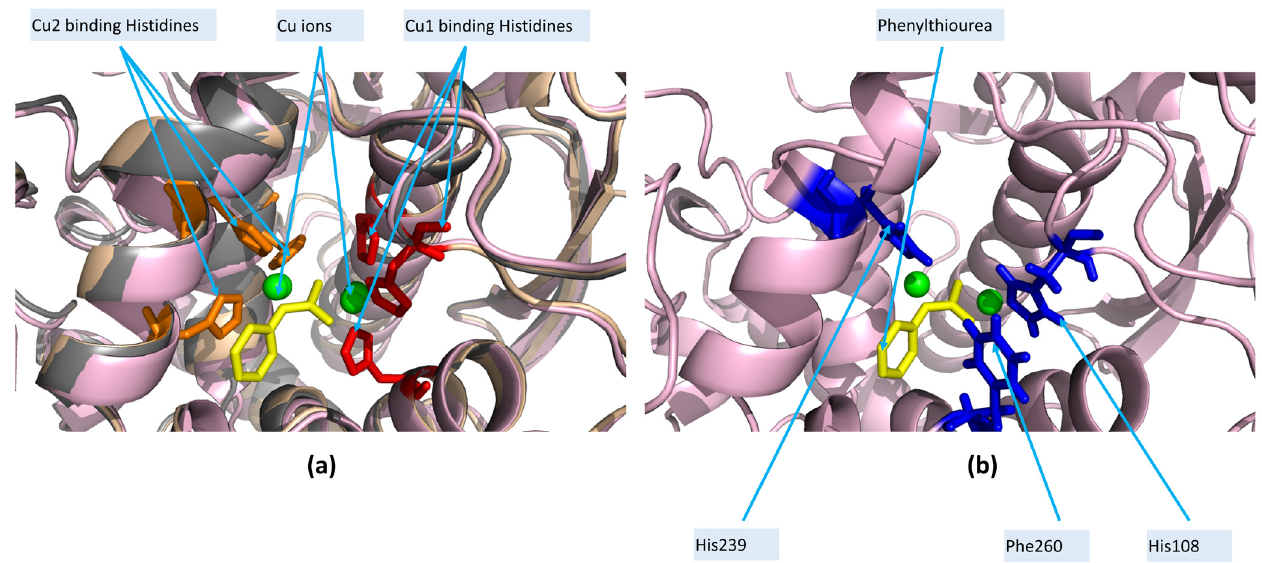
Figure 3. Docking phenylthiourea (URS) to polyphenol oxidase (PPO) from walnut based on the PPO from sweet potato (PDBid:1BUG). The copper binding histidines (His88/109/118 for Cu1) are in red and (His240/244/274 for Cu2) are in orange. URS in yellow, copper ions in green. ( a ) Superimposition of PDBid:1BUG (wheat), modelJrPPO1 (grey) and solvedJrPPO1 (pink). ( b ) Three closest residues in solvedJrPPO1 that ligand URS (His108/His239/Phe260) are in blue.